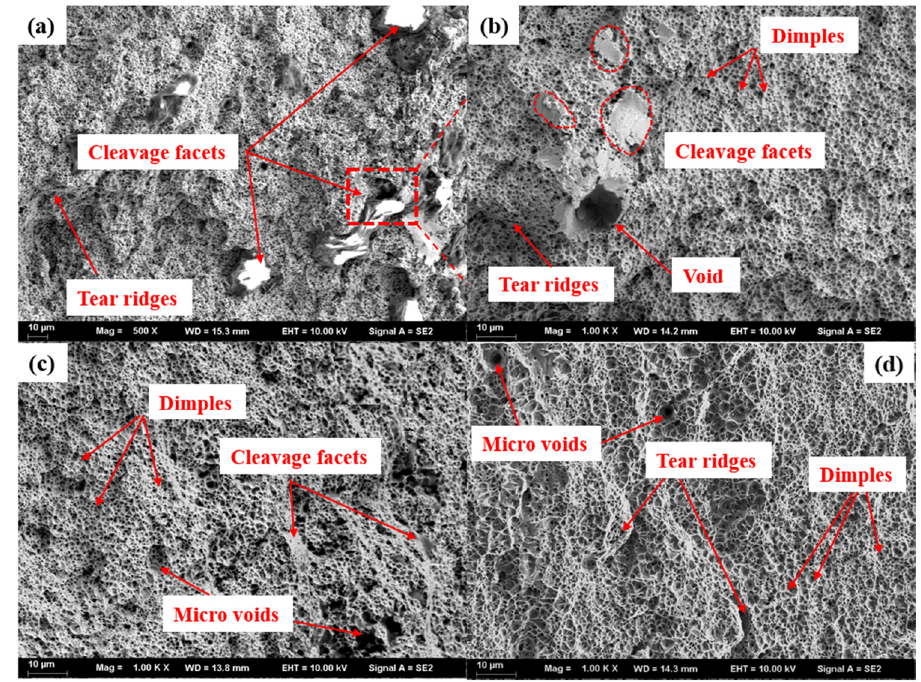
Figure 11: Fracture morphology of tensile specimen of: ( a ) AW joint, ( b ) enlarged detail of ( a ) , ( c ) after LTA, and ( d ) after